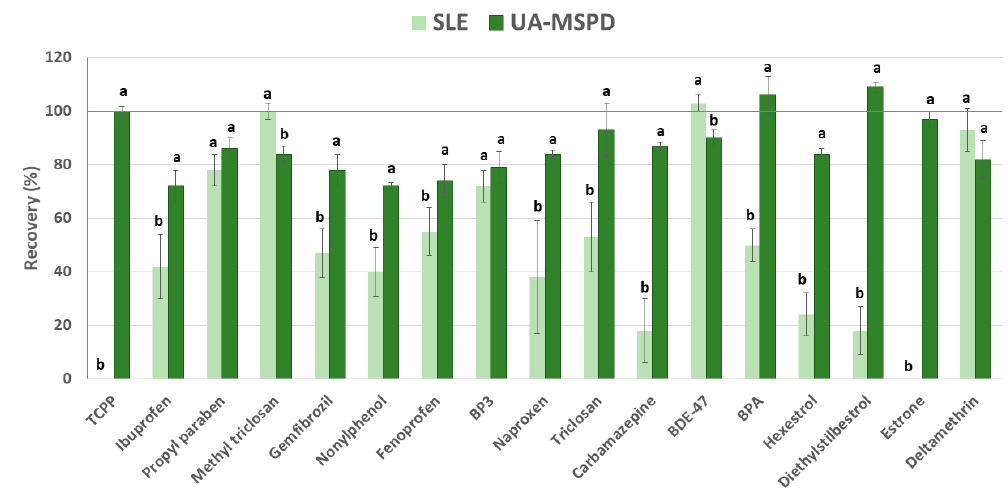
Figure 2. Recovery in percentage of the studied compounds in spirulina spiked at 100 ng · g − 1 employing two extraction procedures, solid–liquid extraction (SLE) and UA-MSPD. Di ff erent letters indicate significant di ff erences ( p ≤